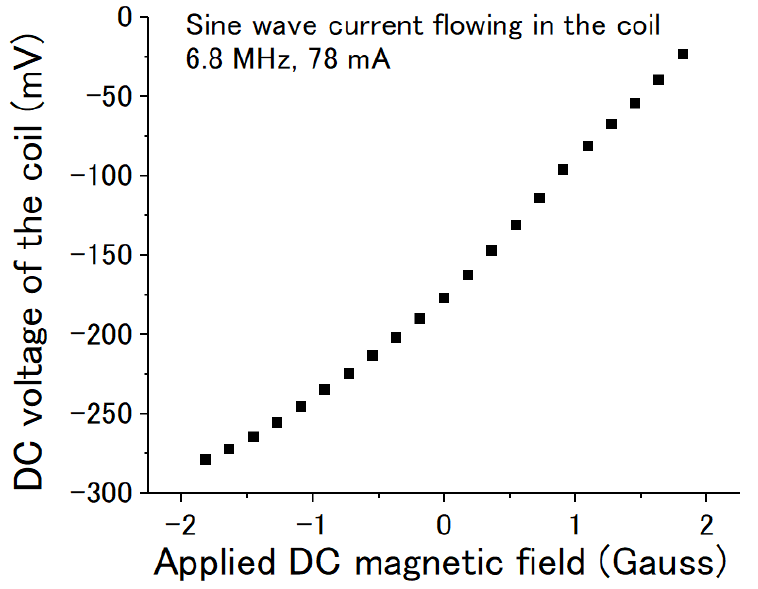
Figure 6. DC voltage of the coil vs the applied DC magnetic field. The sine wave current was 6.8 MHz with a peak-to-peak amplitude of about 78